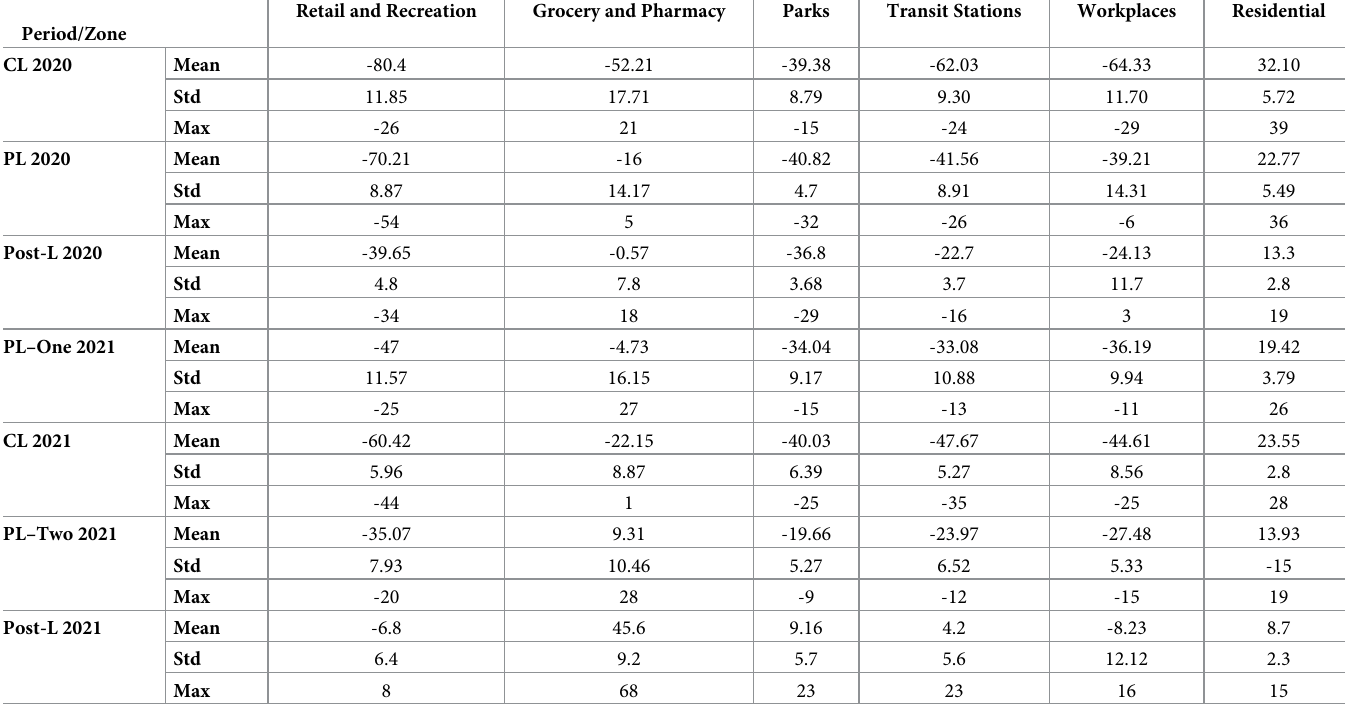
Table 1. Descriptive statistics of the changes in mobility (in %) from baseline during various lockdown phases in both waves in Tamil Nadu in the six spheres of